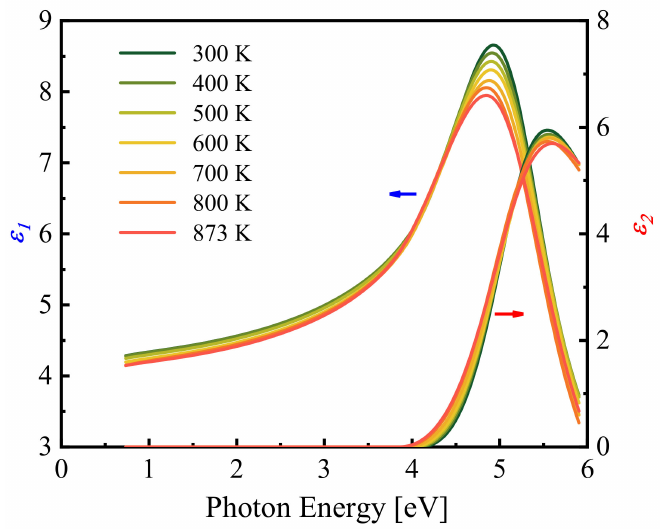
Figure 1. The measured complex dielectric functions of Ta 2 O 5 using an RC2 ellipsometer in the ultraviolet-visible spectral range at temperatures varying from 300 to 873